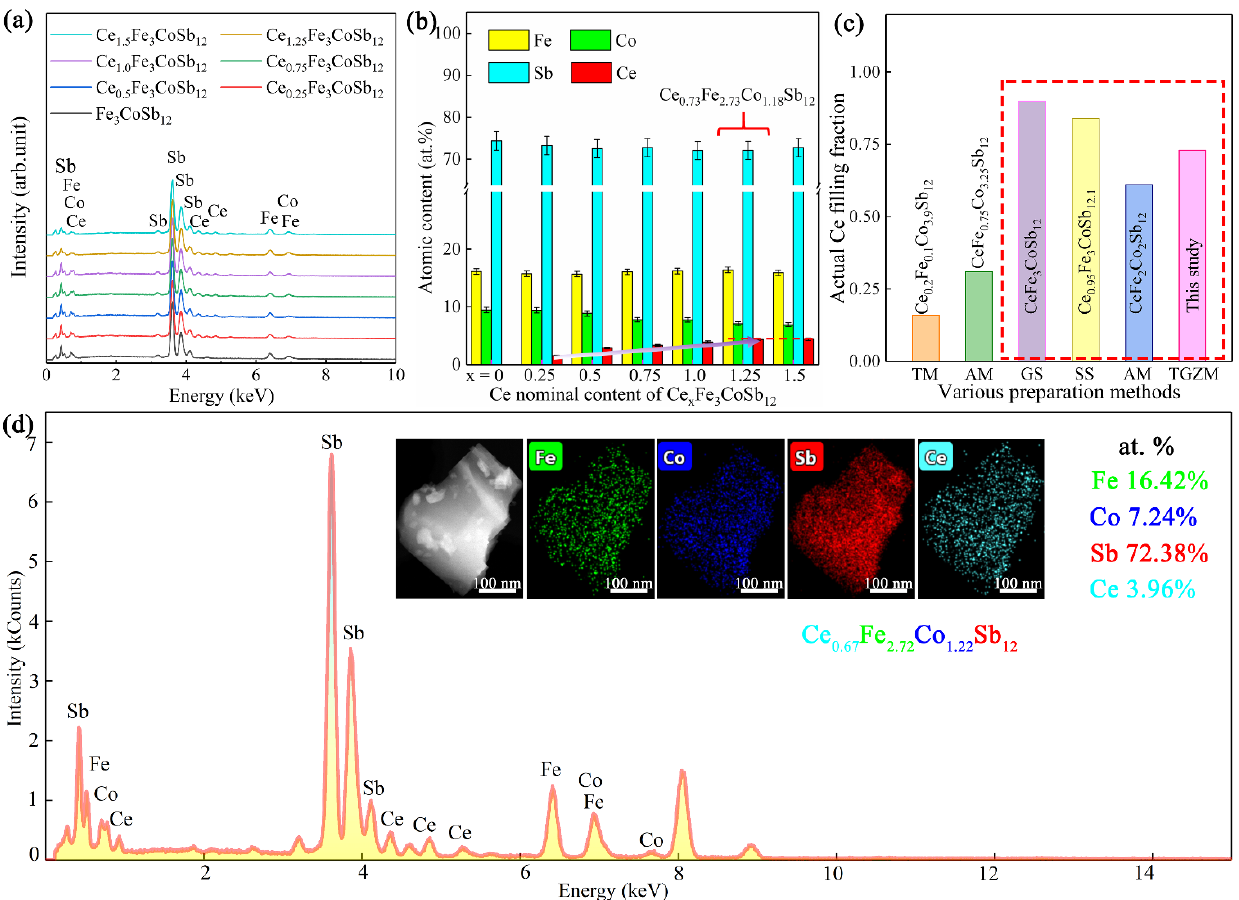
Figure 4. Detailed component information acquired by EDS: ( a ) EDS spectra and corresponding ( b ) average atomic ratios of Fe, Co, Sb, Ce elements in Ce x Fe 3 CoSb 12 (x = 0 to 1.5) samples. ( c ) comparison of the Ce filling fraction in Fe-doped CoSb 3 prepared by different methods, including traditional melting (TM) for Ce 0.2 Fe 0.1 Co 3.9 Sb 12 , [58] arc melting (AM) for CeFe 2 Co 2 Sb 12 [59] and CeFe 0.75 Co 3.25 Sb 12 [39], gas-atomized powder sintering (GS) for CeFe 3 CoSb 12 , [45] scanning laser melting and spark plasma sintering (SS) for Ce 0.95 Fe 3 CoSb 12.1 [46] and temperature gradient zone melting (TGZM) for this study. ( d ) Typical TEM-EDS spectrum of the CeFe 3 CoSb 12 . The insert of ( d ) is the HAADF image, corresponding elemental maps and component analysis.